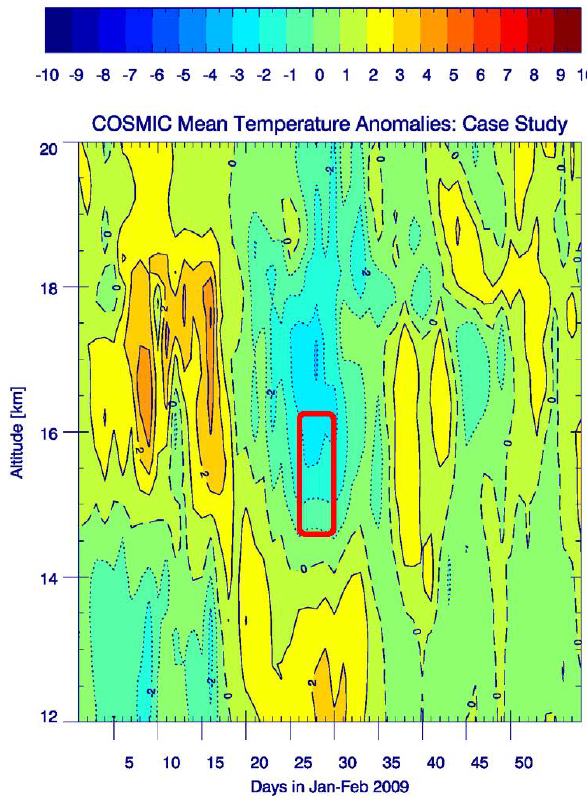
Fig. 6. Timeseries of daily mean temperature anomalies observed by COSMIC within the area of coincidence. Anomalies are derived by subtracting the monthly mean temperature within the area. Average cold point temperatures over this period are below 190K.